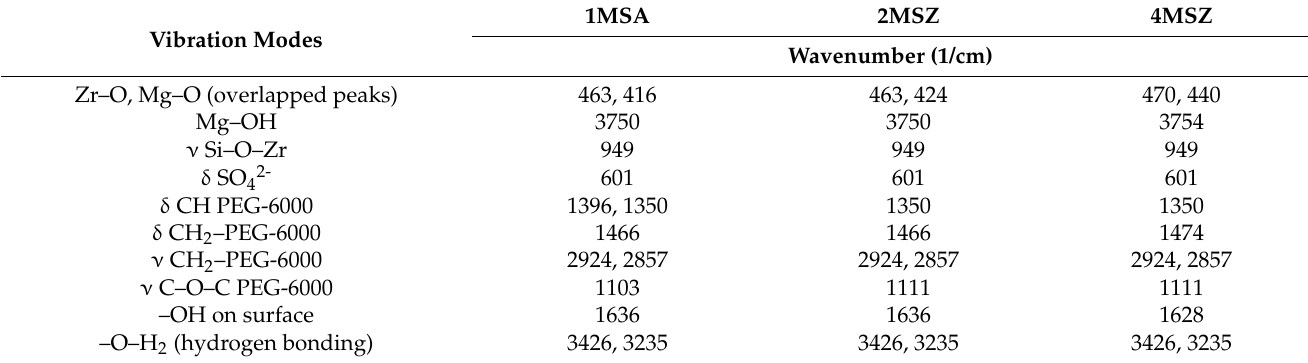
Table 2. The results of FT-IR identification on the as-synthesized MSZ